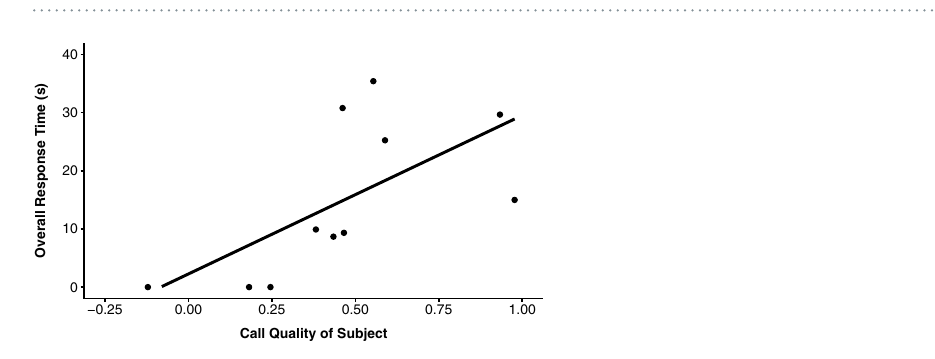
Figure 3. Status difference for males in overall response time to high- and low-quality calls. Figure 3 represents both ( a ) within subject differences for 20 bachelors and 20 leaders, and ( b ) mean total response time ( + SEM) to different call types.